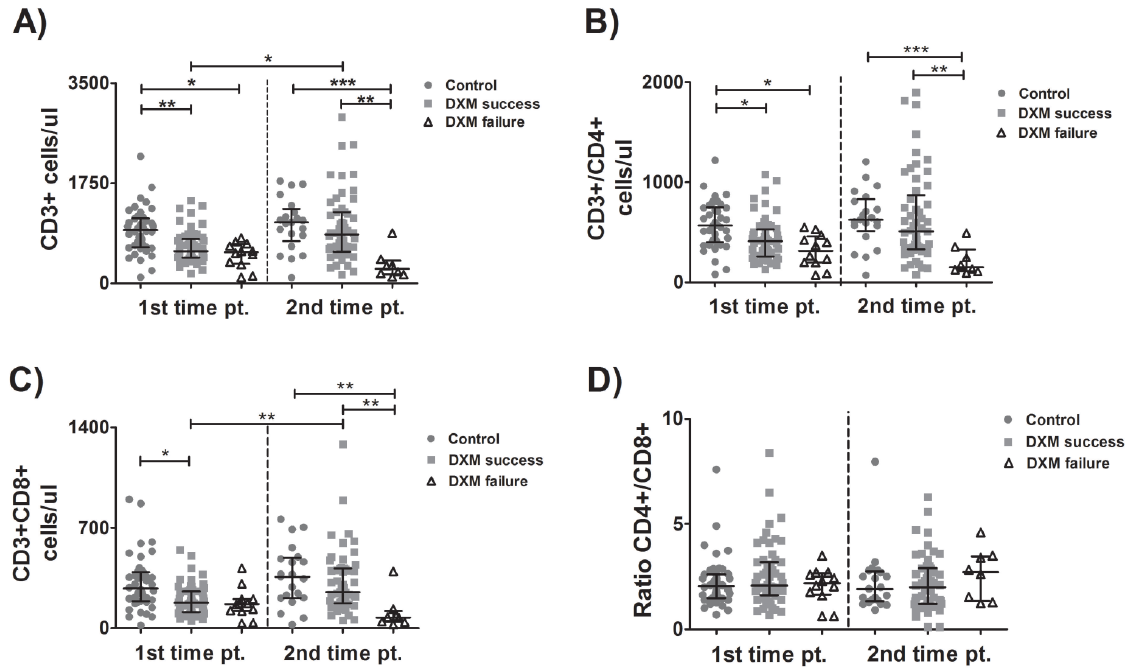
Figure 1. Kinetics of CD4 and CD8 T-lymphocytes. Lymphocyte subpopulations were evaluated